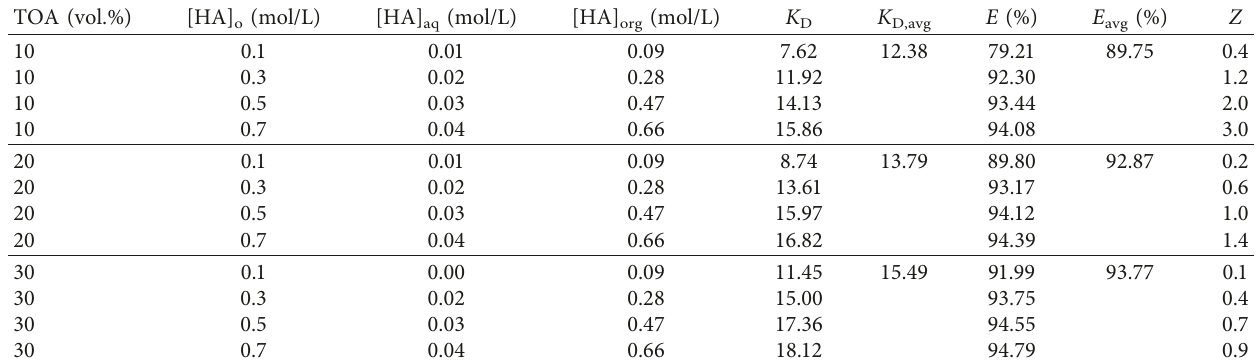
Table 2: Extraction equilibrium results for succinic acid and TOA in sunflower oil biodiesel at 298K. TOA (vol.%)